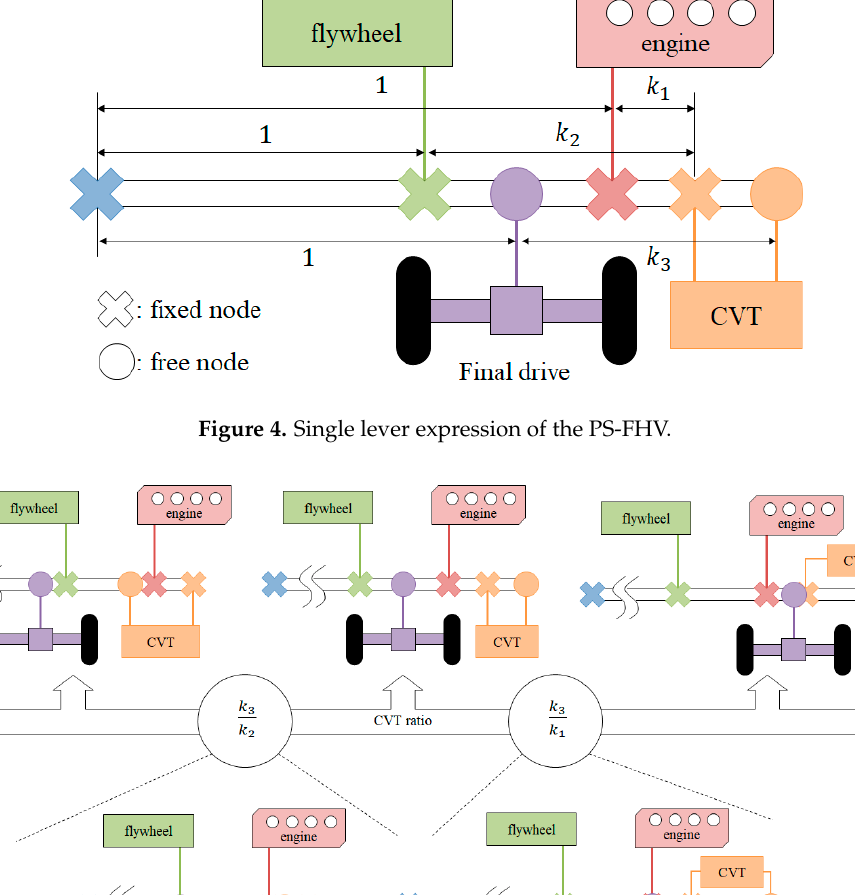
Figure 3. Lever analogy result of each PGS and CVT in the PS-FHV configuration. Energies 2018 , 11 , x FOR PEER REVIEW